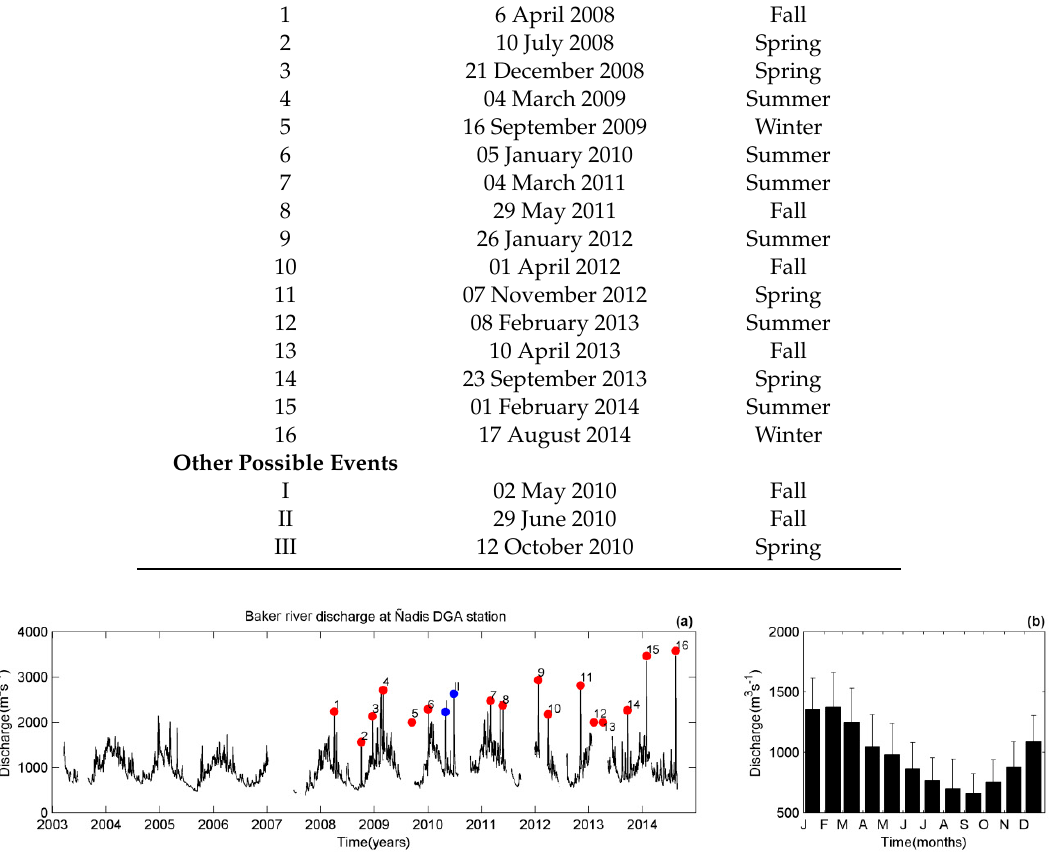
Figure 2. ( a ) Time series of Baker river discharge at the DGA Ñadis station from 2003–2014. The red dots denote the GLOF events reported by the DGA and blue dots represent other possible GLOF events. ( b ) Long-term monthly mean river discharge with the standard deviations. Table 1. GLOF events reported and validated by the Chilean Water Directorate.